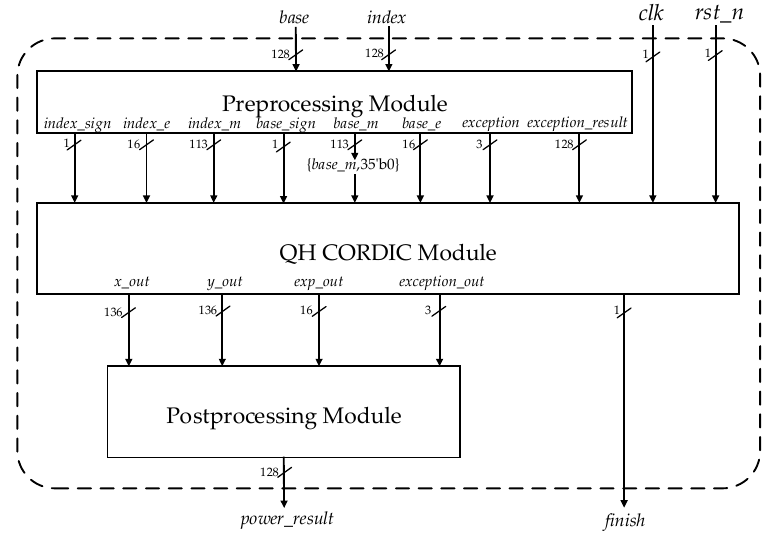
Figure 1. Overall architecture of quad-precision FP X Y -like functions.